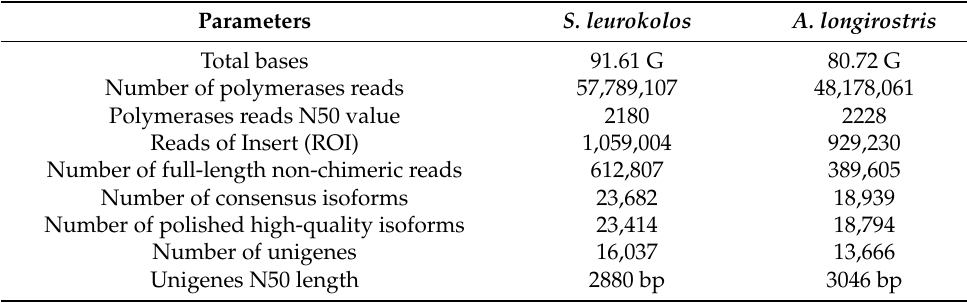
Table 1. Information of Iso-Seq in S. leurokolos and A. longirostris by PacBio Sequel II platform.